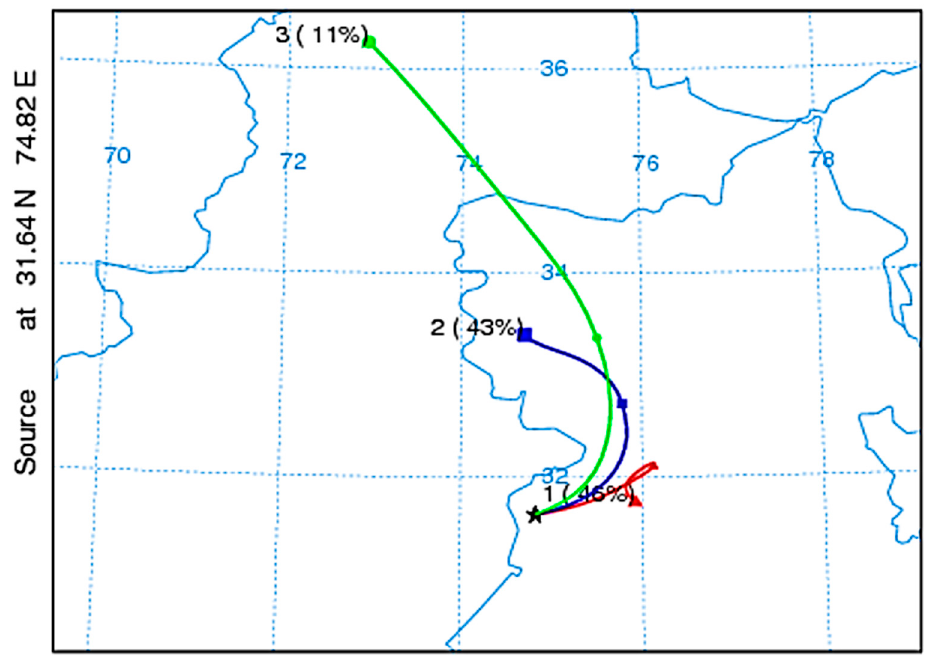
Figure 10. Cluster analysis of air mass back trajectories calculated at a height of 500 m above ground level for sampling days. Cluster 1 showing 46% contribution (red line), Cluster 2 showing 43% contribution (blue line) and Cluster 3 showing 11% contribution (green line) in origin of air masses.